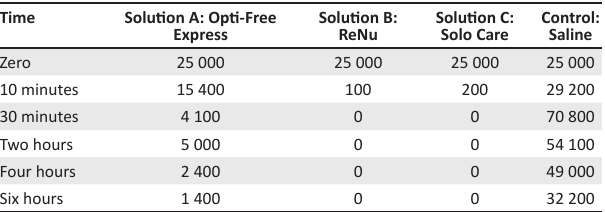
TABLE 2: Actual colony counts per solution per time interval.